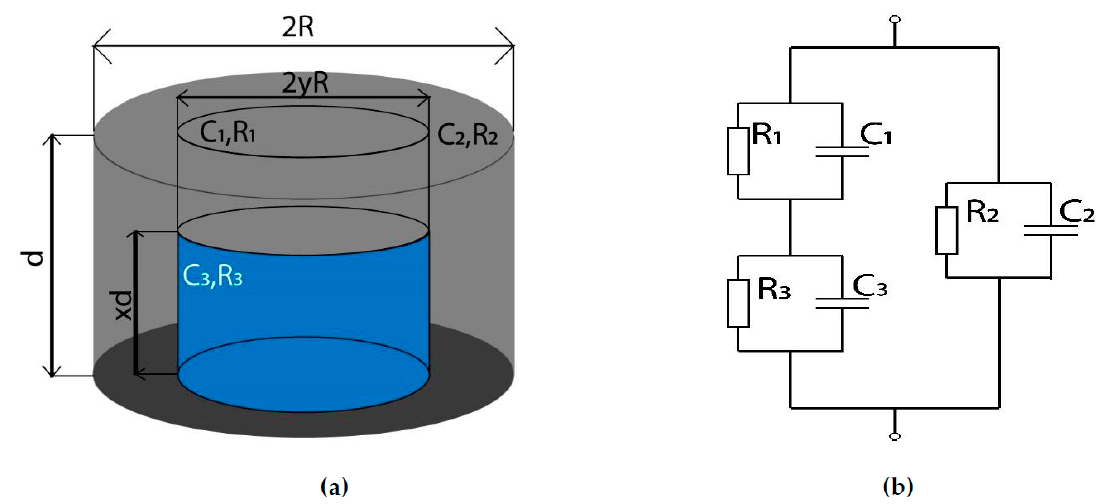
Figure 3. ( a ) Geometrical parameters of an MAE sample with compacted filler aggregate and ( b ) the Figure 3. (a) Geometrical parameters of an MAE sample with compacted filler aggregate and (b) the corresponding equivalent electrical corresponding equivalent electrical circuit.